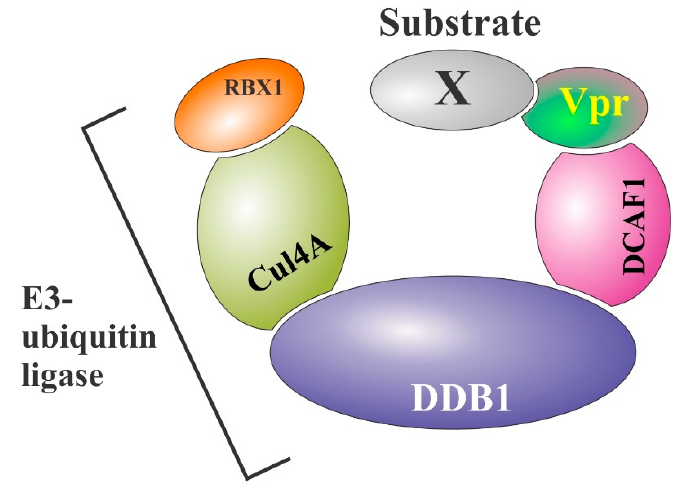
Figure 3. Schematic structure of the CRL4DCAF1 E3 ubiquitin ligase complex assembled by Vpr for the ubiquitination and subsequent degradation of Vpr-interacting substrates (X). Binding of cellular factor X (e.g., HLTF, Exo1, Mus81, ZIP, Tet2, and other thus unidentified substrates) to Vpr induces its poly-ubiquitination through the Vpr-associated E3 ubiquitin ligase complex, which marks these proteins for subsequent degradation by the cellular proteasome machinery.